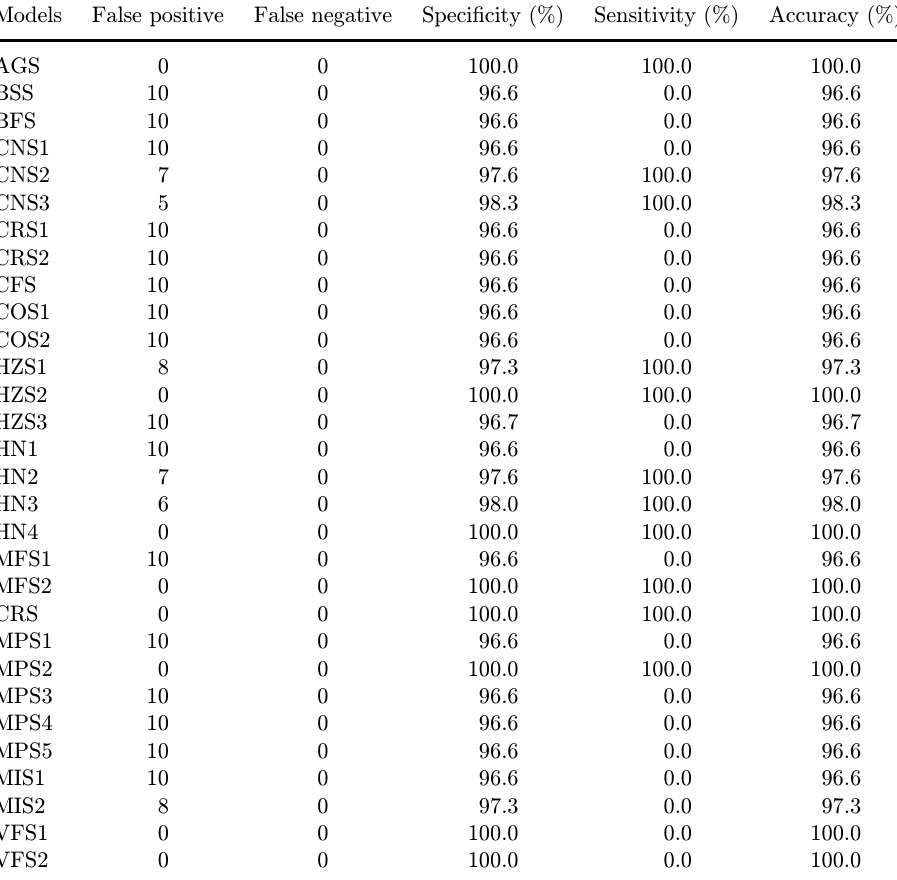
Table 2. Results of identi¯cation types of syrup using PLS-DA